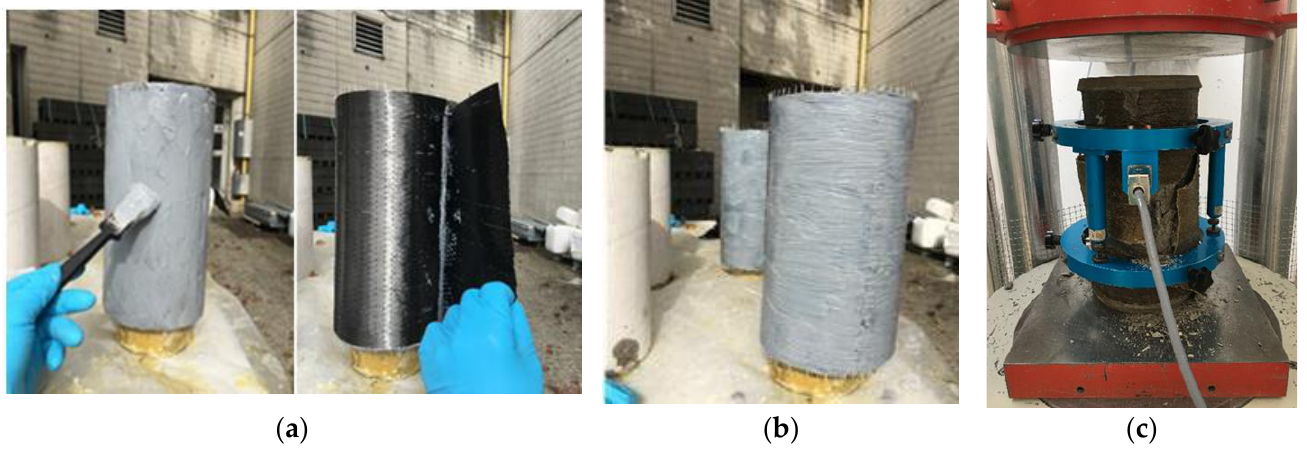
Figure 1. Preparing specimens with CUS jackets. CUS: unidirectional carbon fiber fabric reinforced with epoxy polymer. ( a ) resin application then CUS fabric laying, ( b ) manual dry impregnation of fabric, ( c ) test setup and instrumentation.